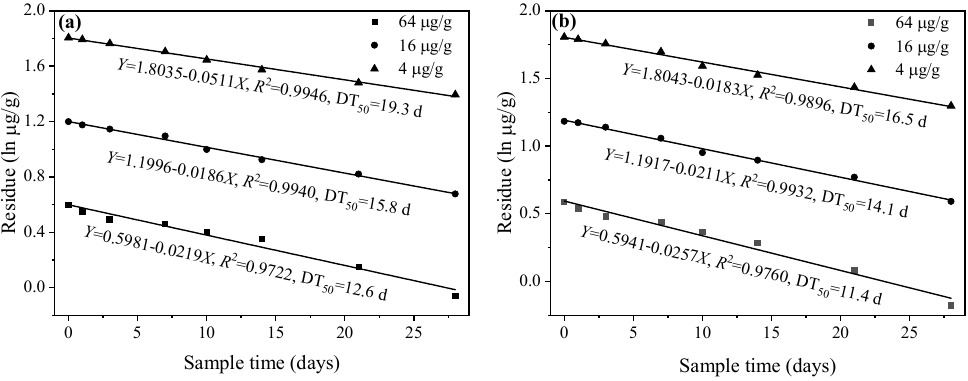
Figure 5. Degradation of Rac - ( a ) and S -metolachlor ( b ) in the soil.